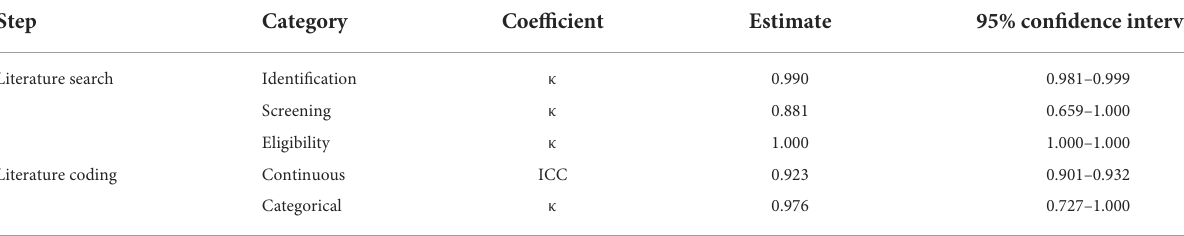
TABLE 4 Interrater reliability and agreement of the literature search and